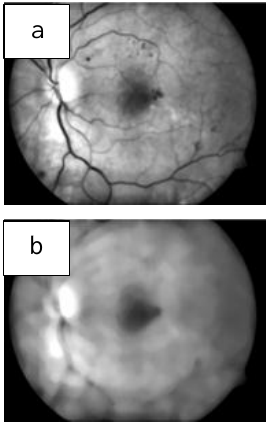
Fig. 7. The image results